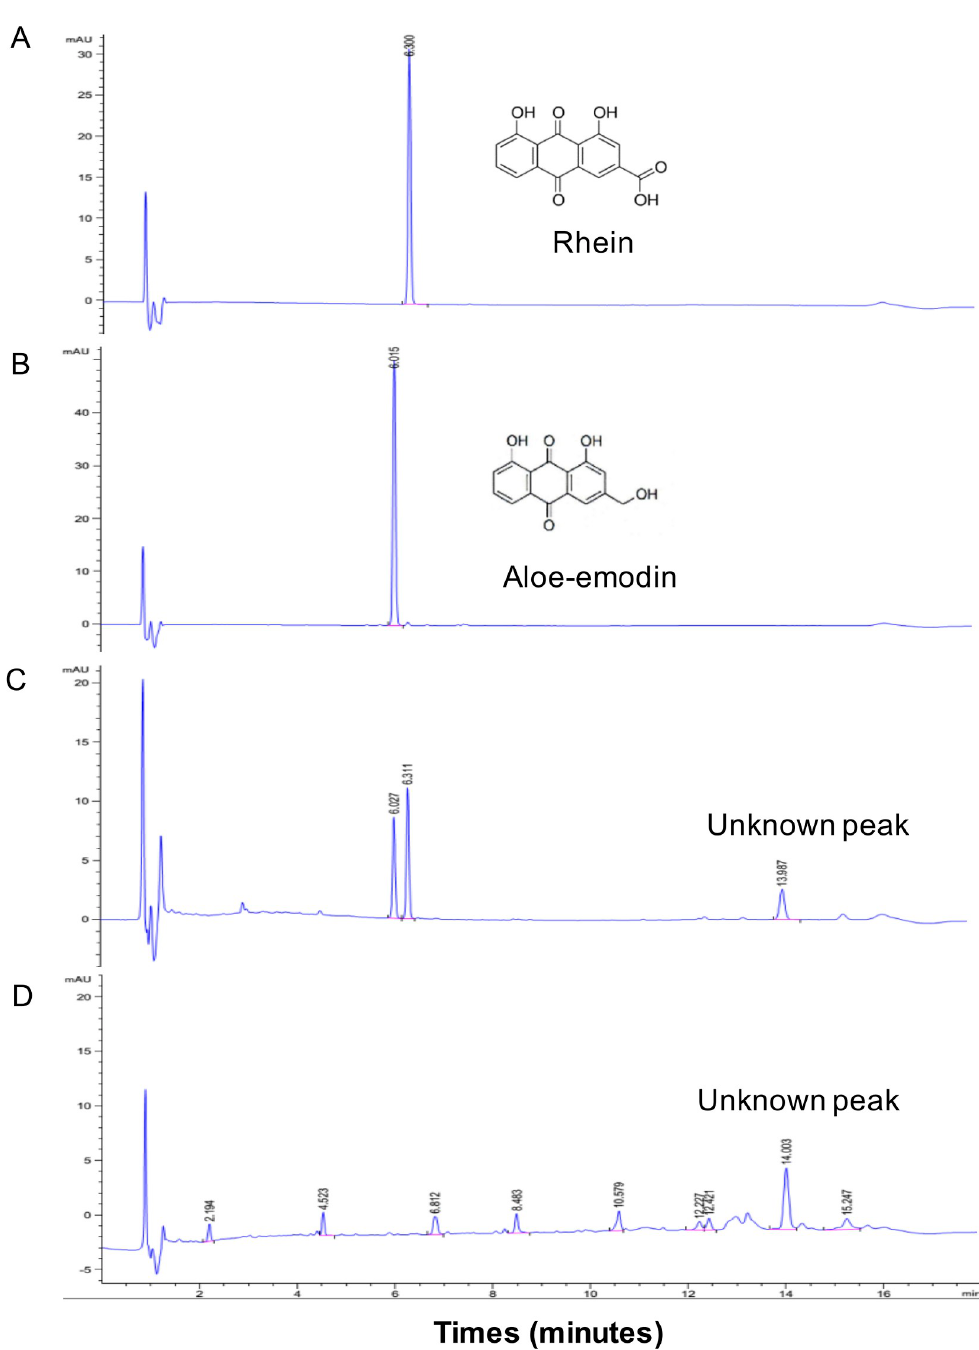
Fig 3. HPLC profiles of the anthraquinone compounds. Rhein (A) and aloe-emodin (B), in the ethanolic extracts of S . alata (C) and S . tora